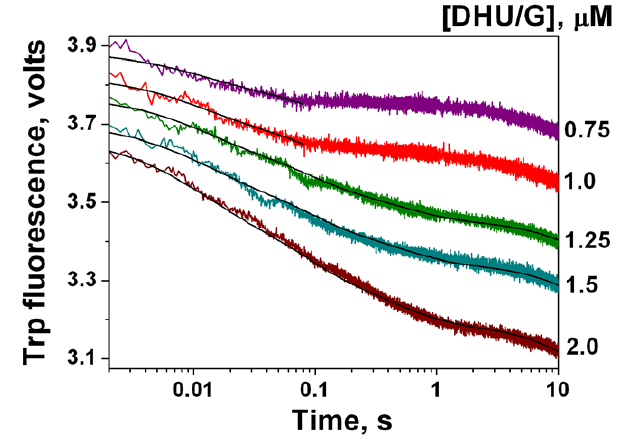
Figure 8. Trp fluorescence traces of APE1K98A (1 m M) upon interaction with the substrate DHU/G. The reaction was carried out in NIR buffer. Smooth curves are the result of the fitting procedure. Concentrations of the substrate are indicated next to the right axis.